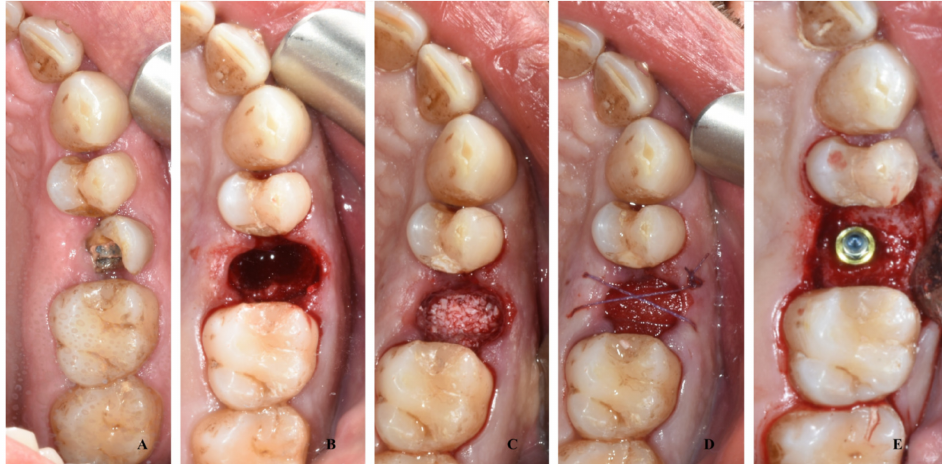
Figure 1. A case of socket preservation performed with a sponge of deproteinized bovine bone inside the alveolar socket covered with a resorbable collagen matrix and the insertion of a dental implant after four months: preoperative image ( A ); image after the extraction ( B ); image after the filling with deproteinized bovine bone ( C ); image after placement of collagen matrix and suture ( D ); image after recovery at time of implant surgery ( E ).